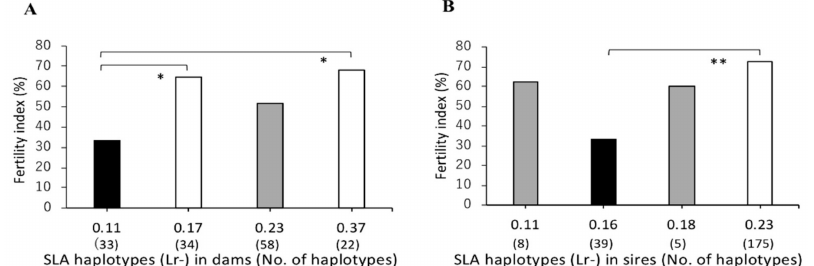
Figure 2. Comparison of fertility indices among SLA class II haplotypes in homozygous MMPs. X -axis shows the haplotypes of homozygous dams ( A ) and sires ( B ) and the number of matings for each haplotype in brackets (no. of haplotypes). The Y -axis shows the fertility index as indicated by the ratio (%) of the number of deliveries to the number of matings, expressed as the mean value (bar). Black and white bars represent lower, and higher fertility indices, respectively, of the mean values and the significant di ff erences among haplotypes are indicated by the asterisks. Probabilities of significant di ff erences among haplotypes are indicated by single ( p < 0.05) and double ( p < 0.01) asterisks. Gray bars represent the mean values of the fertility indices without significant di ff erences among the